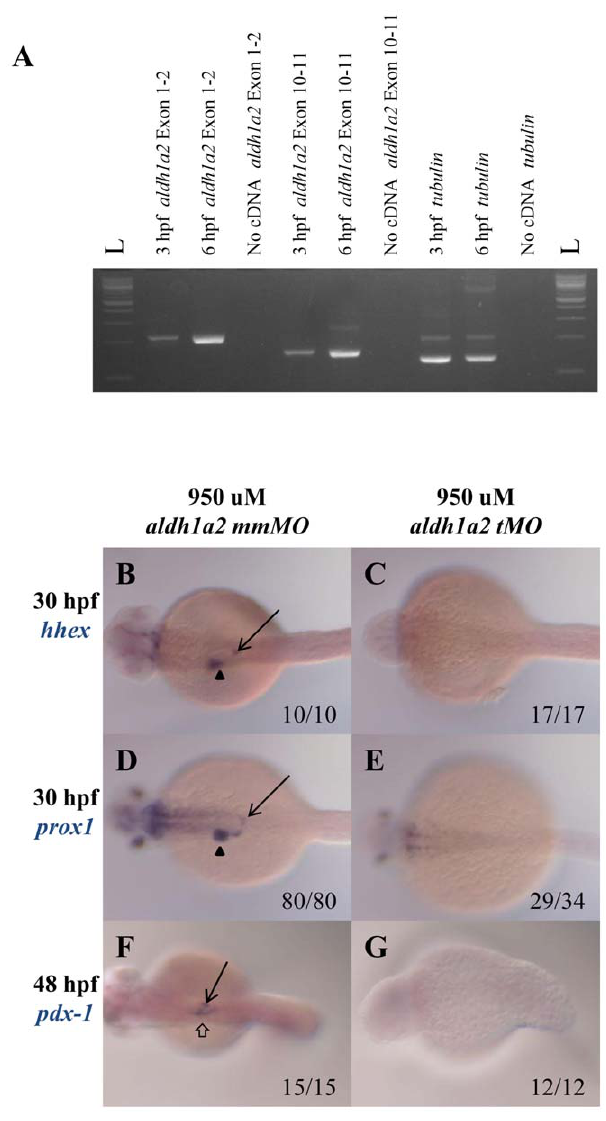
Figure 5. aldh1a2 is maternally expressed and aldh1a2 transla- tional morpholino knocks down endoderm expression. A. PCR of 3 and 6 hpf wild type embryos using primers targeting exon1-2 and exon10-11 of aldh1a2 reveals aldh1a2 expression already at 3 hpf. A no DNA sample and amplification of tubulin is used as negative and positive controls. B–G. Wild type embryos were injected with either 950 uM aldh1a2 mismatch (mm) morpholino (MO; B, D, F) or 950 uM of aldh1a2 translational (tMO; C, E, G) and assayed for expression of hhex (B, C), prox1 (D, E) or pdx1 (F, G). Embryos are in dorsal view with anterior to the left.